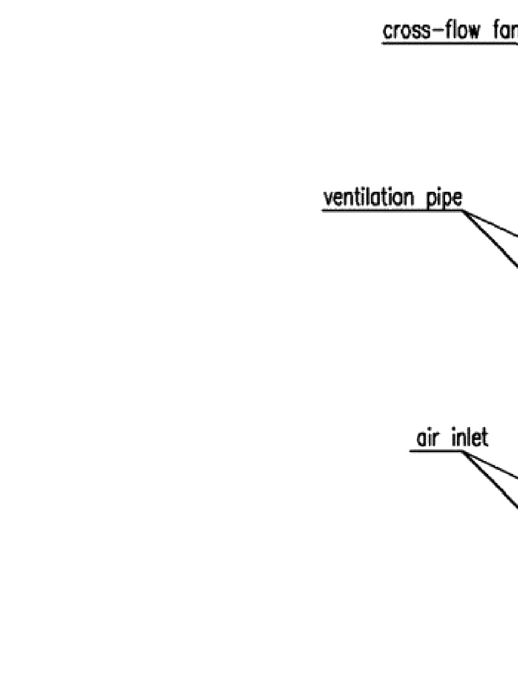
Frontiers in Energy Research |